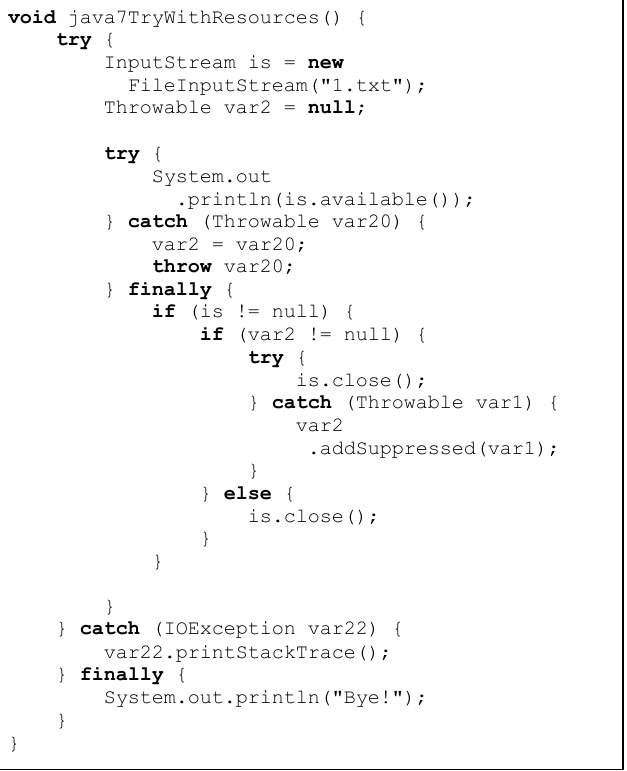
Fig. 18. Try-with-resources